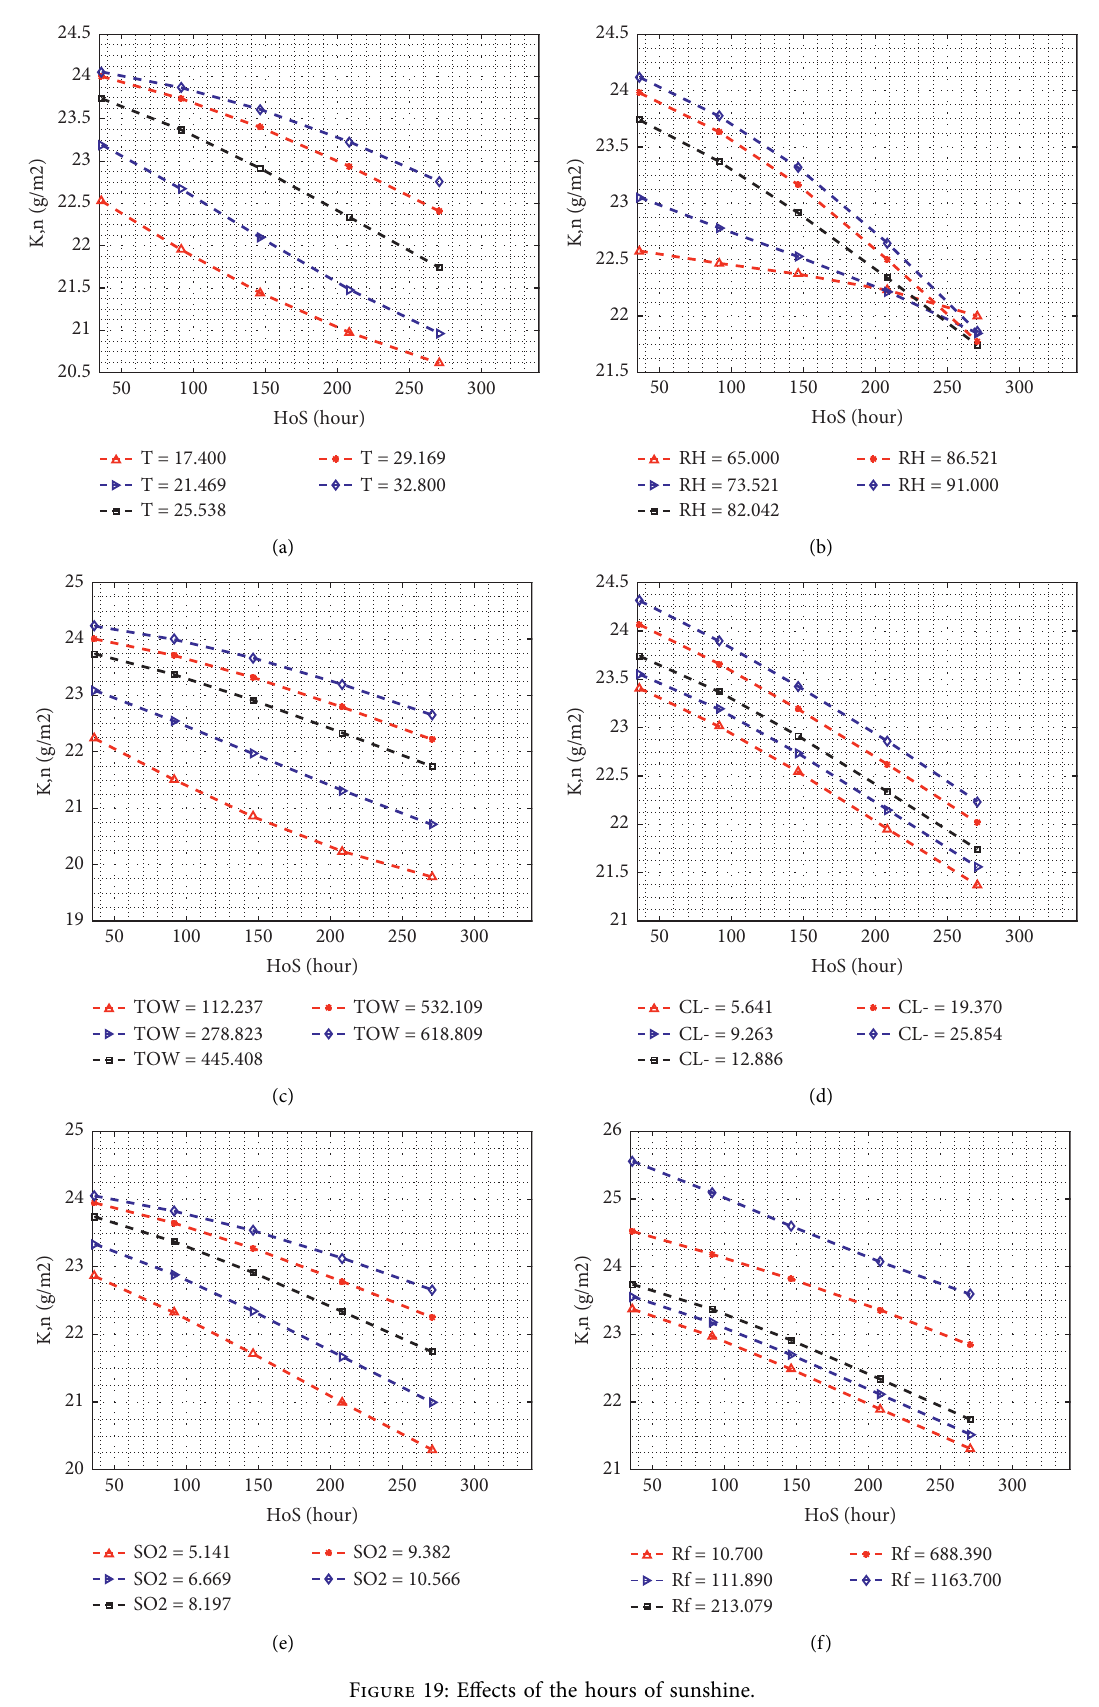
Figure 19: Effects of the hours of